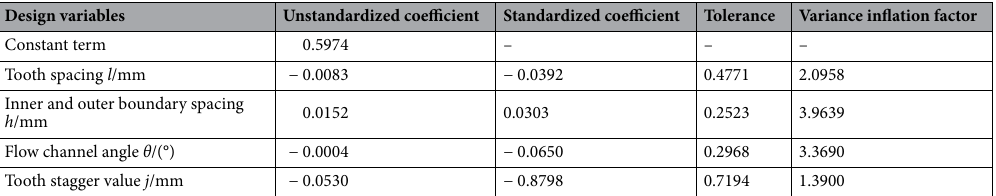
Table 4. The results of the linear regression